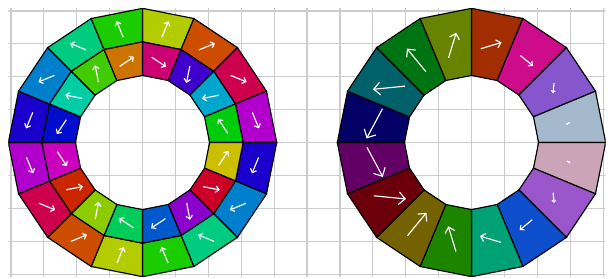
FIG. 6. Left: Halbach quadrupole nested inside a dipole. Right: vector sum of magnetization vectors in a single